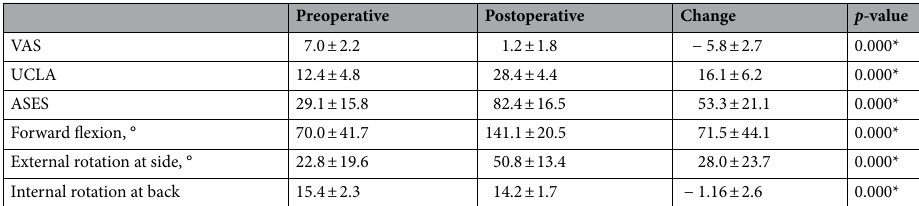
Table 4. Clinical outcomes and range of motions: preoperative, postoperative, and change. VAS visual analog scale, UCLA University of California at Los Angeles, ASES American shoulder and elbow surgeon. *Statistical